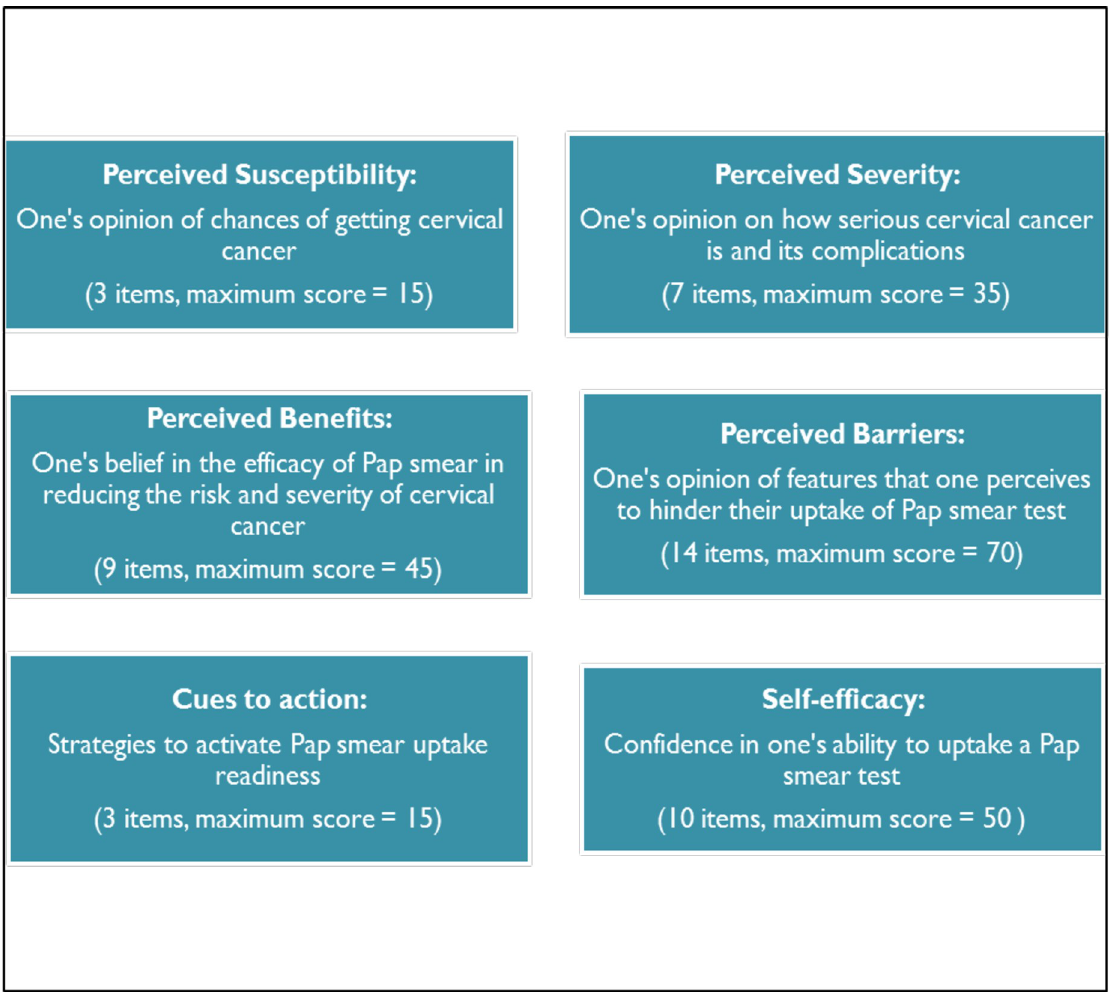
Fig 1. Health Belief Model constructs measured in the